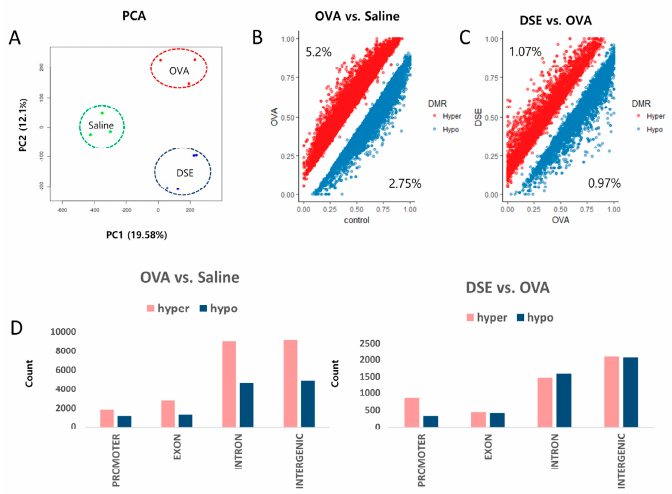
Figure 2. Genome-wide methylation profiling in DMRs. PCA plot of DNA methylation data. Samples are colored according to the experimental group ( A ). Scatter plot of DMRs in OVA vs. saline control ( B ). Scatter plot of DMRs in DSE vs. OVA ( C ). Distribution of DMRs in OVA vs. control ( left ), and DSE vs. OVA ( right ) ( D ).